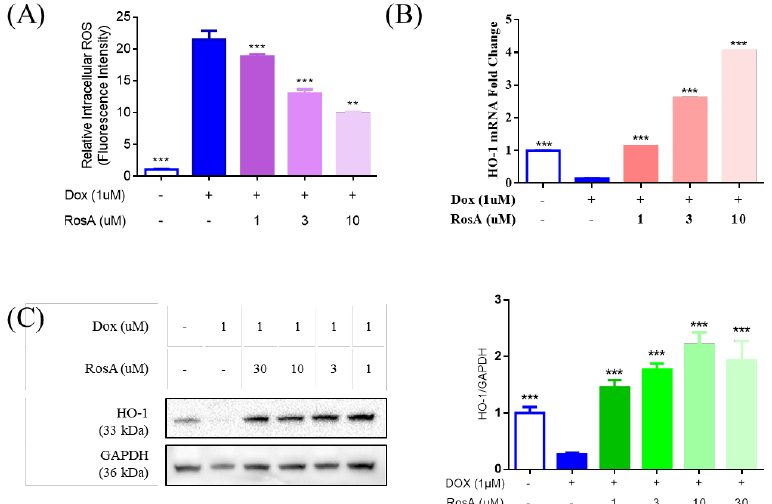
Figure 6. The antioxidant e ff ect of RosA in Dox-induced AC16 injury model. ( A ) The levels of intracellular ROS were measured by DCFH-DA fluorescence. ( B ) The mRNA levels of HO-1 were evaluated using real-time polymerase chain reaction (RT-PCR), with GAPDH as the internal control. ( C ) Levels of HO-1 expression with various concentrations of RosA for 24 h as measured by Western blot, with GAPDH as an internal control. ** p < 0.01, *** p < 0.001, 1 µ M Dox-treated was the model group; 0.25% DMSO-treated was the negative control group, compared with the model group. Results are expressed as mean ± SD ( n = 3).